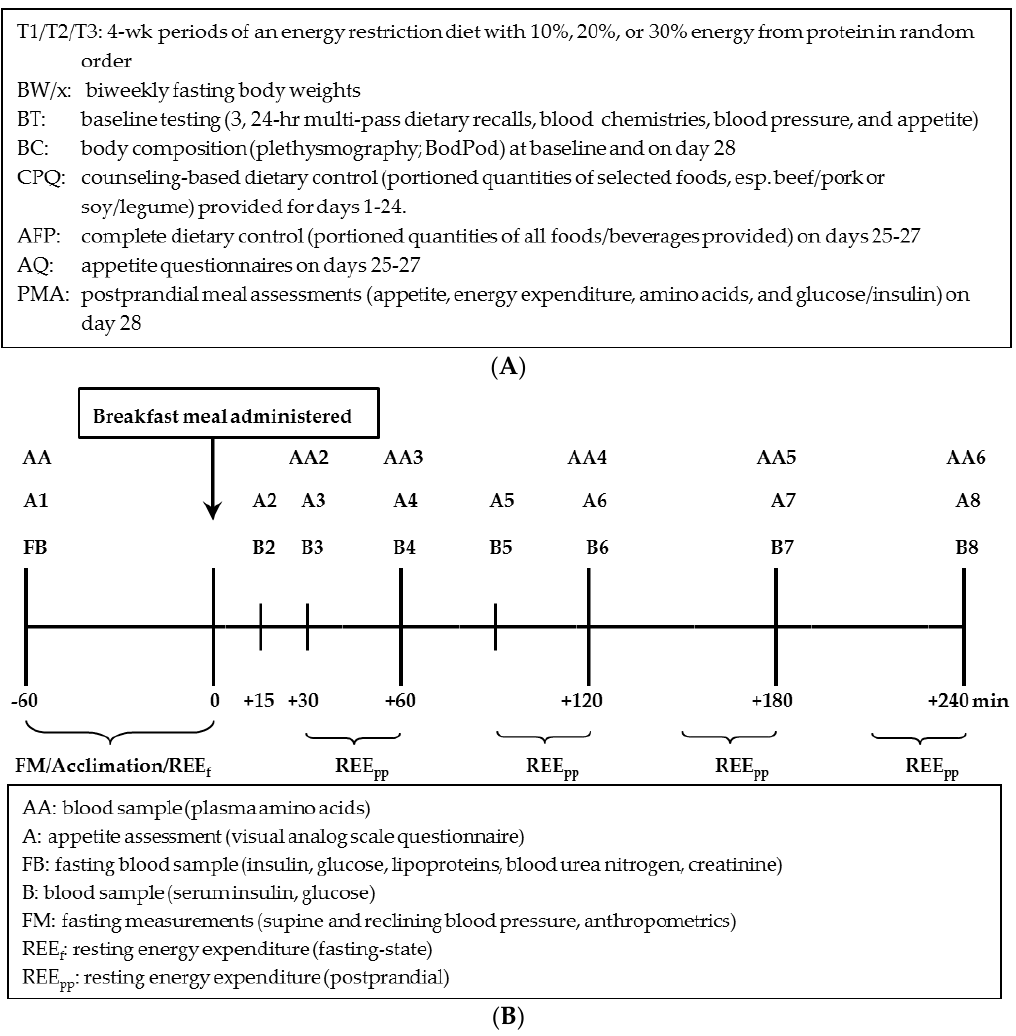
Figure 2. Schematic representation of study design and timeline: ( A ) longitudinal; ( B ) acute study at the end of each 4-week period (day